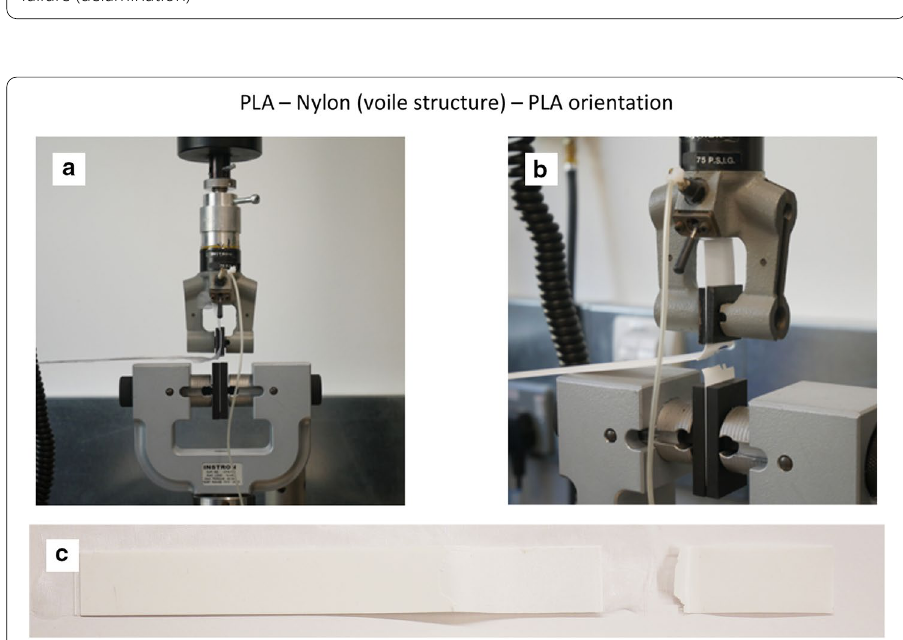
Fig. 6 a Test setup, b failure mode for the PLA—Nylon (voile structure)—PLA orientation and c failure of an adherend (cohesive substrate